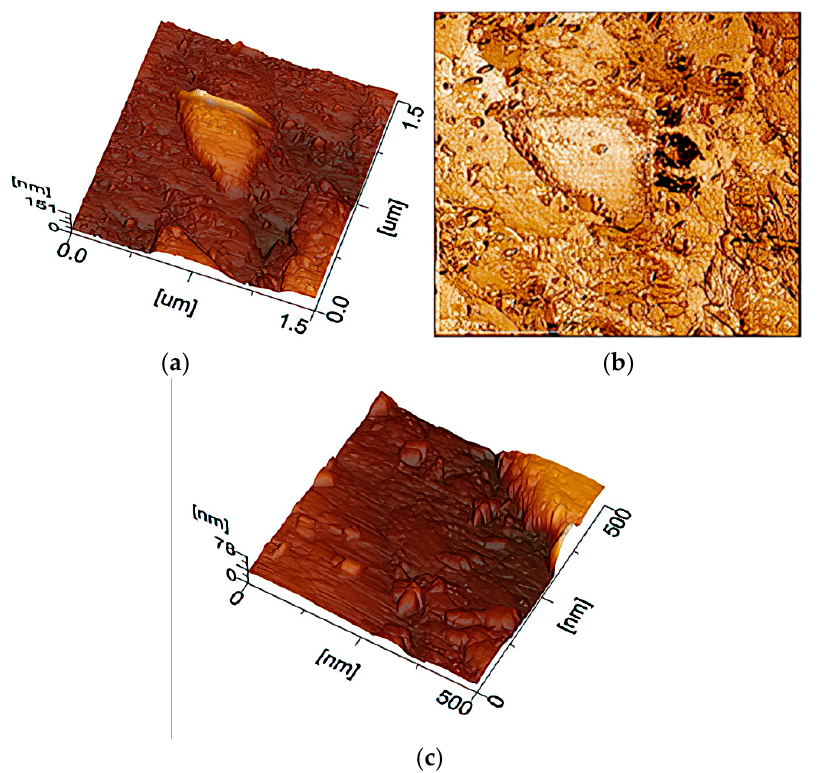
Figure 3. AFM images of a sample with 20 coating layers, scan scale—1.5 × 1.5 μ m: ( a ) topography mode; ( b ) phase mode; ( c ) topography mode.